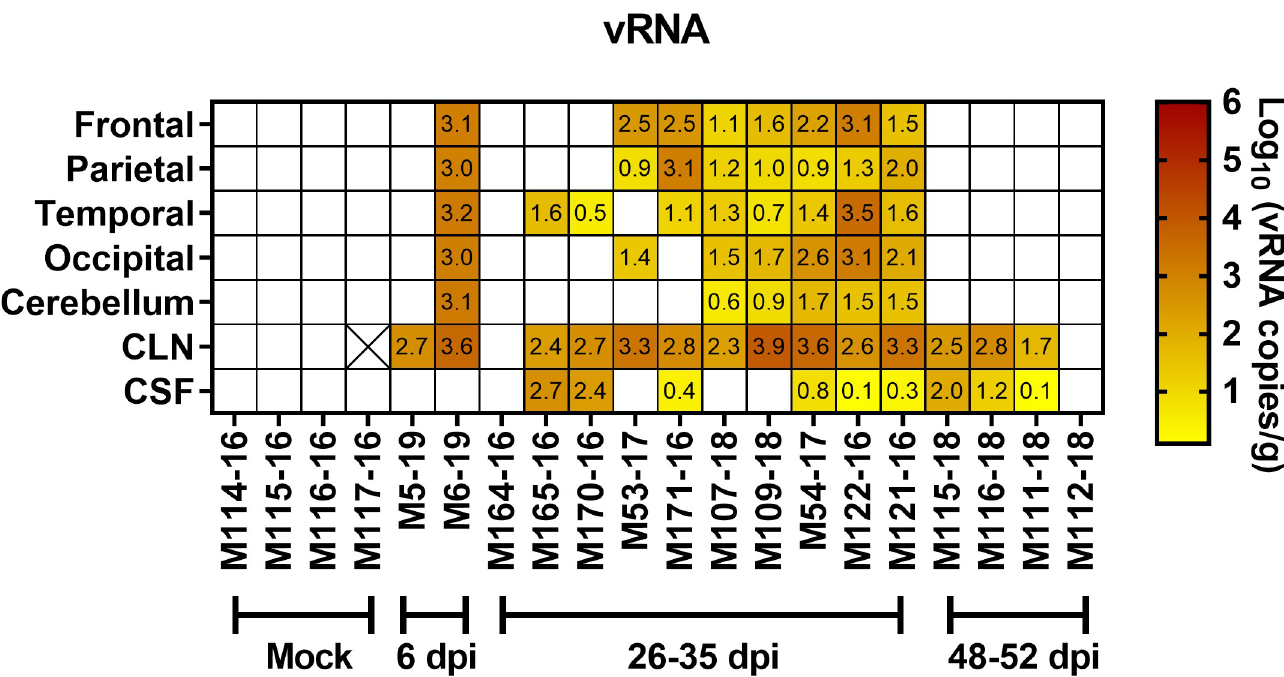
Fig 9. VEEV RNA levels in the tissues of NHPs at necropsy. (A) Brain tissue, cervical lymph nodes (CLN), and cerebrospinal fluid (CSF) from VEEV-infected animals euthanized at the end of the study were subjected to q-RT-PCR for viral RNA. Numbers in each cell represent the log 10 vRNA copies/g or ml (for CSF) after subtraction of background and correspond to the heatmap colors. Blank/white cells were below the limit of detection (LOD). Infectious virus was not detectable in these samples by plaque assay. Numbers on x-axis indicate day post-infection (dpi) that the animals were euthanized. Two animals (M5-19 and M6- 19) were euthanized at 6 dpi during acute disease; the rest were > 25 dpi at the end of our study period. The cell with an X represents a tissue sample that was not available for testing.